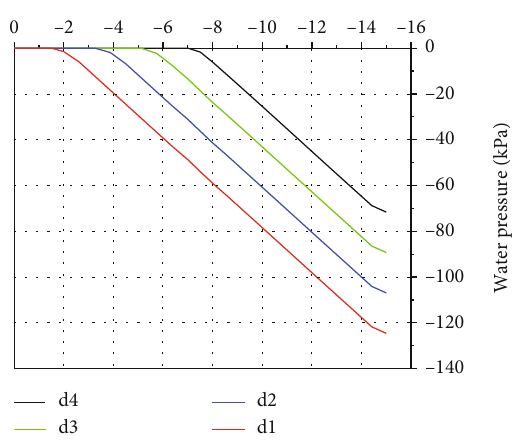
Figure 18: E ff ect of rising groundwater level on water pressure.